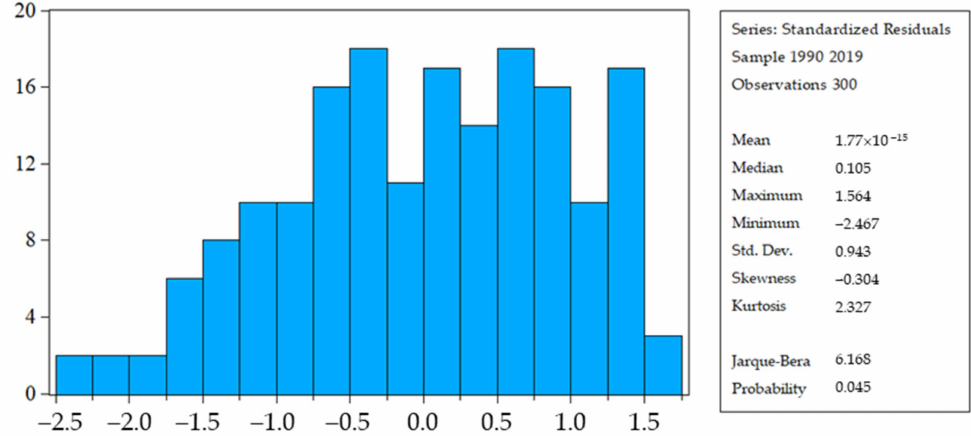
Figure 3. Descriptive Statistics of Standardized Residuals.